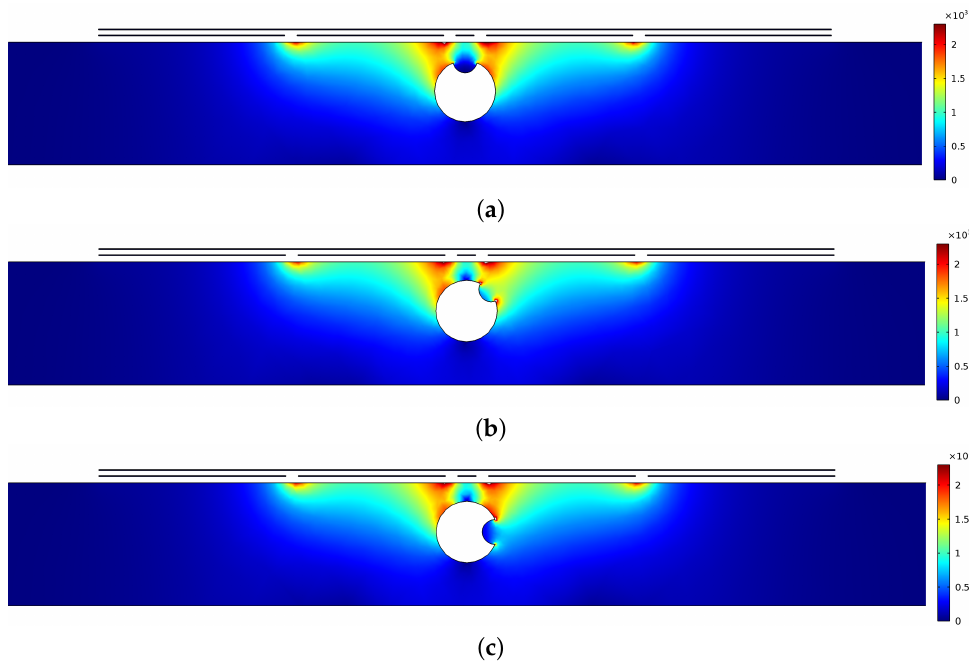
Figure 6. Simulations of the electric field distribution (V/m) in the xz plane for a concrete slab with rebar. The rebar contains surface defect at different positions: ( a ) 0º, ( b ) 45º and ( c ) 90º with respect to the electrodes